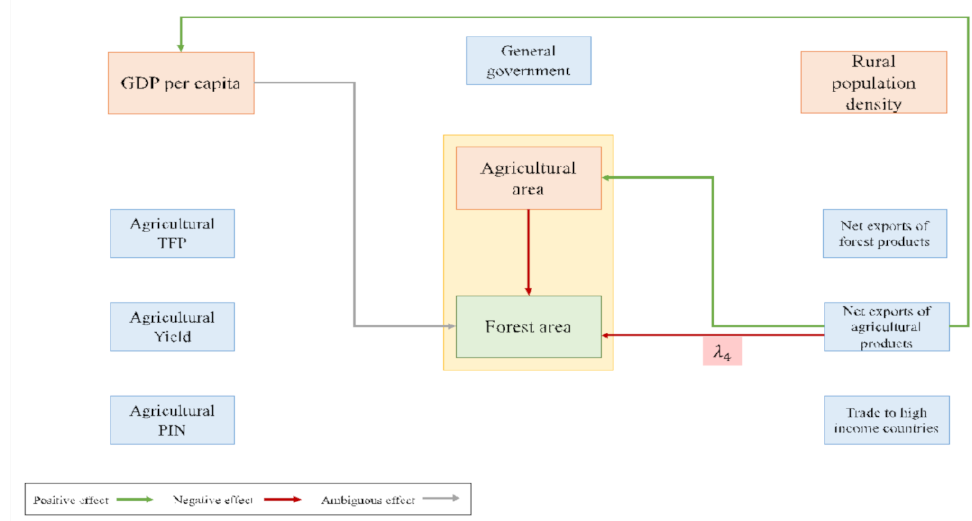
Figure A5. Estimating indirect effects of “Net exports of Agricultural products” variable.